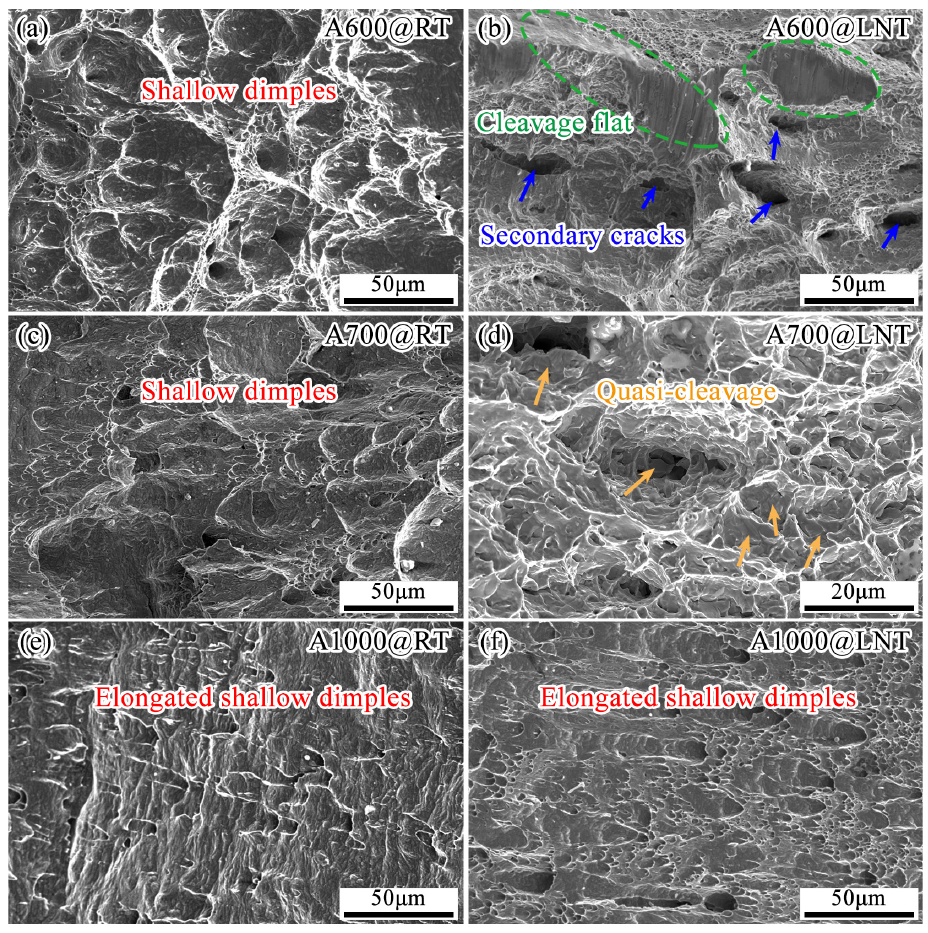
Figure 6. SEM fractographs of impact specimens ( a , b ) A600, ( c , d ) A700, and ( e , f ) A1000 at ( a , c , e ) RT and ( b , d , f ) LNT. Blue arrows point to secondary cracks. Green dashed lines indicate cleavage flat areas. Yellow arrows indicate quasi-cleavage.